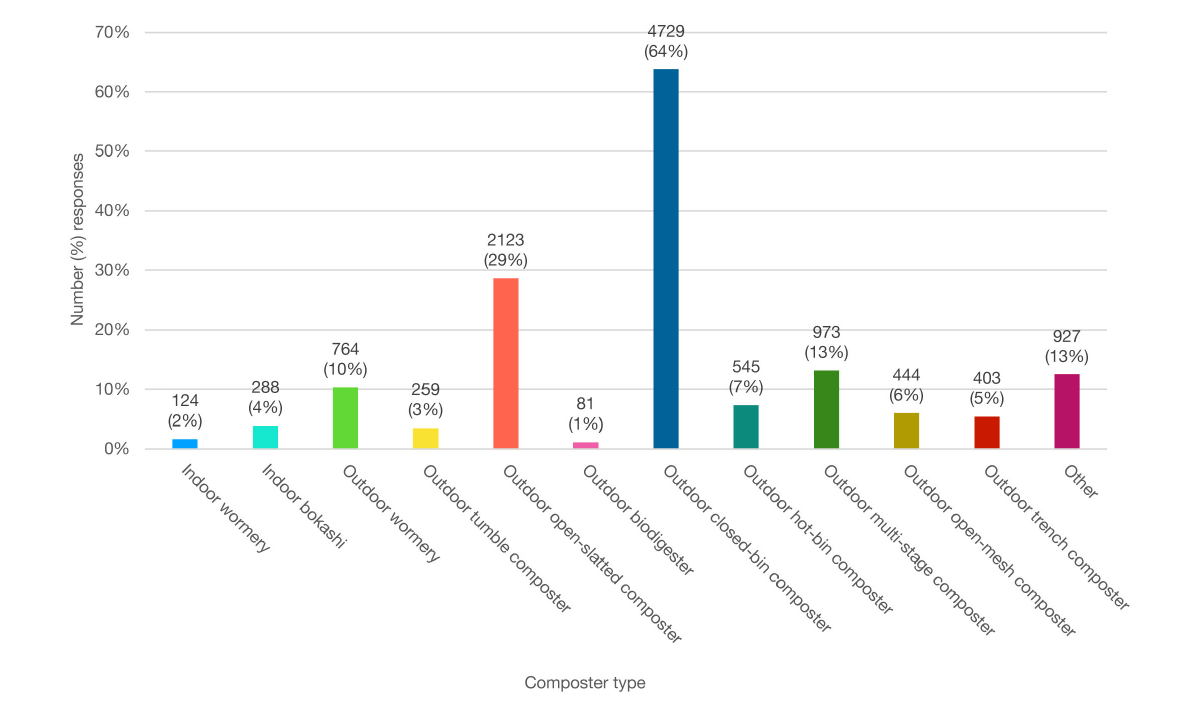
FIGURE4 Chart showing the frequency and types of composter used by survey participants. Values calculated from 7,413 participants who home compost. Multiple responses included.